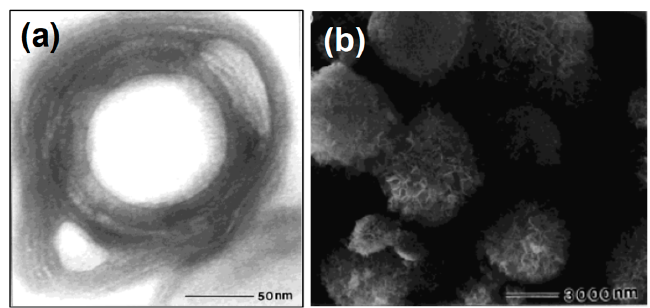
Figure 5. ( a ) TEM micrograph of the silica obtained from the gel with 25 in acetic acid after sectioning, ( b ) SEM micrograph of the silica obtained from the gel with 25 /Pd(NO 3 ) 2 in aniline. Reproduced with permission from Reference [78].